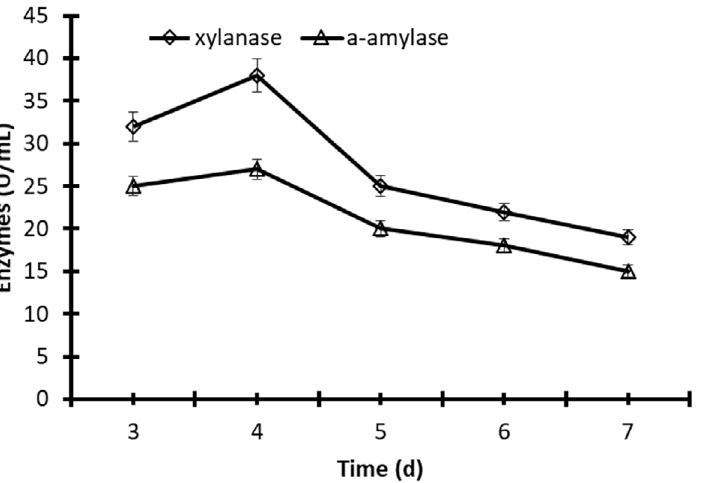
Fig. 2. Production of xylanase and α-amylase by fermentation of Pichia membranifaciens AUN-02 in Erlenmeyer flasks at 30°C and 150 rpm. The data were considered as means ± S.E.